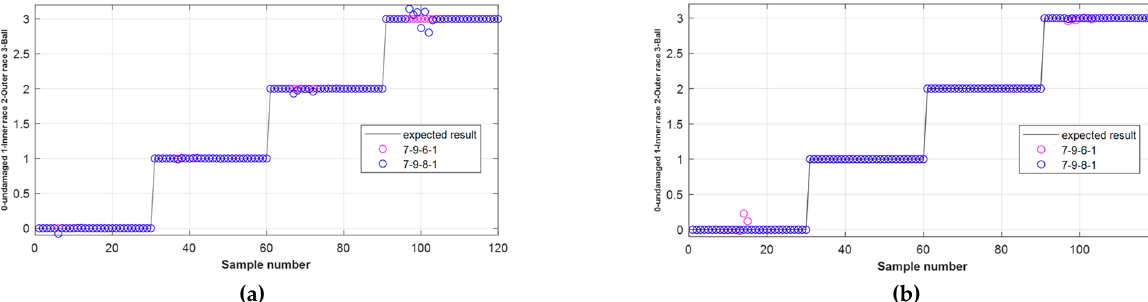
Figure 9. Waveforms of output values from the MLP-based fault classifier (type II) using the tansig activation function, trainlm learning method, learning rate η = 0.5 for various MLP structures based on the ENV ( a ) or FFT ( b ) analyses.